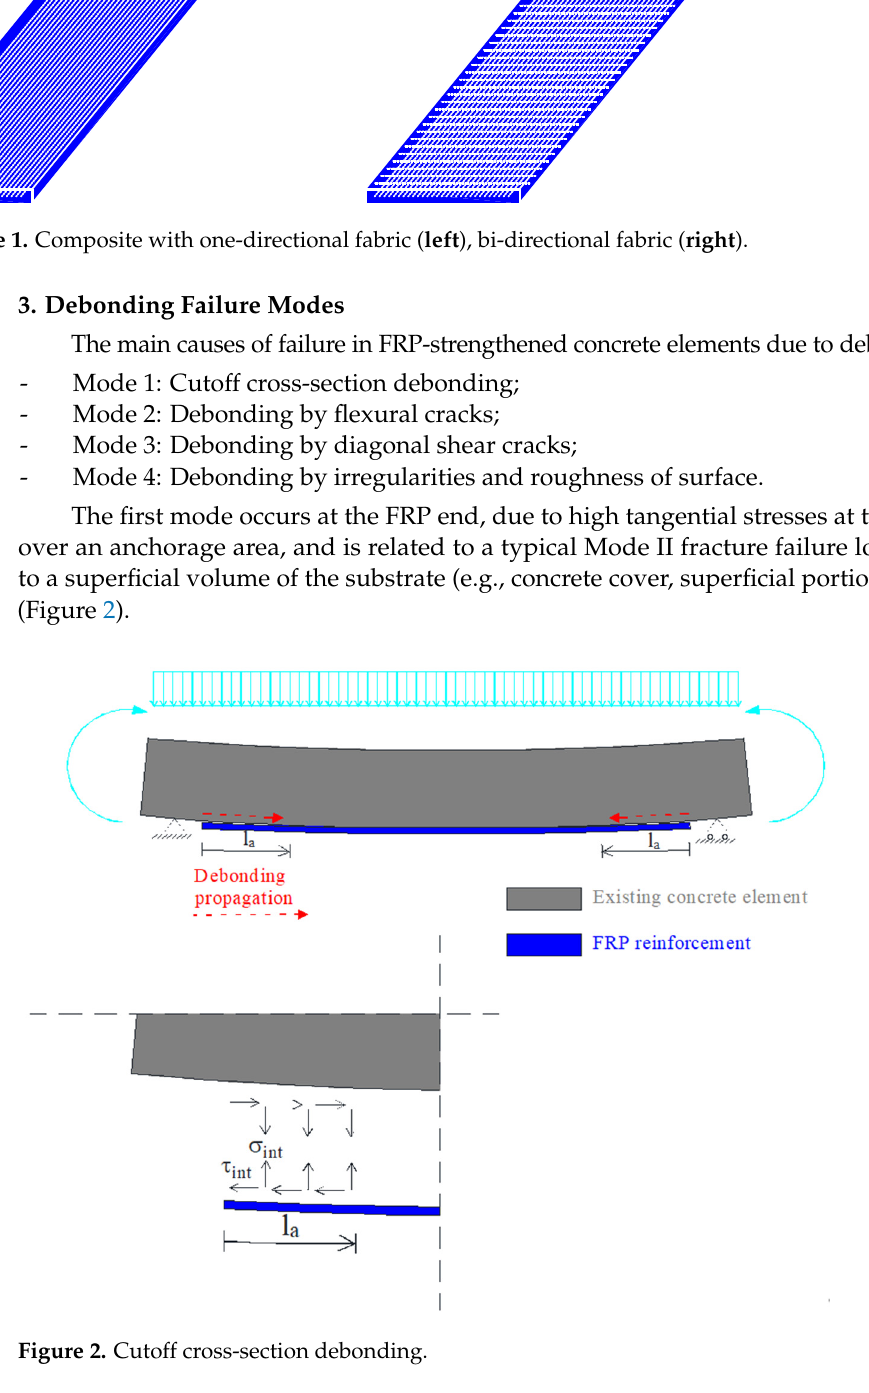
Figure 1. Composite with one-directional fabric ( left ), bi-directional fabric ( right ).